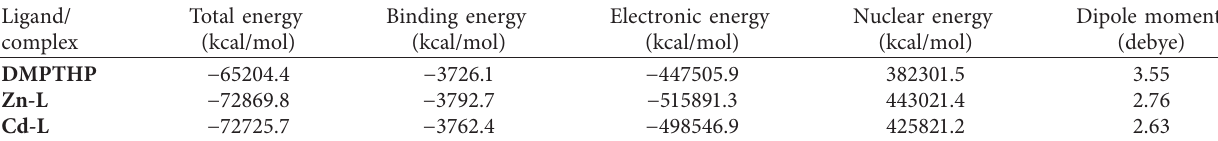
Table 3: Some energetic properties of the DMPTHP ligand and M(II)-DMPTHP complexes.